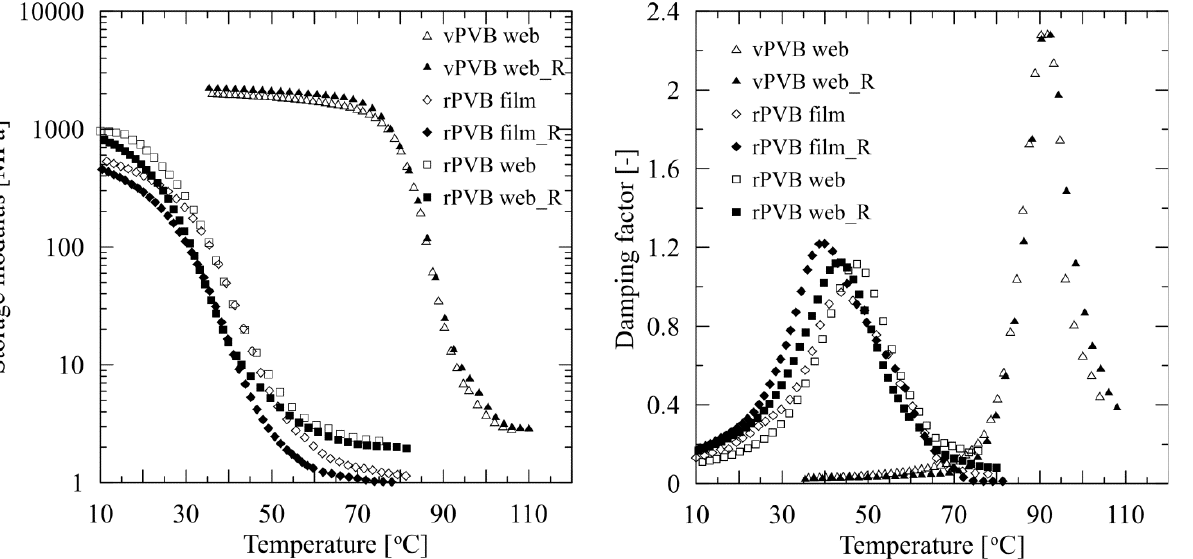
Table 7. Evaluation of T g of rPVB and vPVB films using DMA measurements. Tested Sample Sample Code